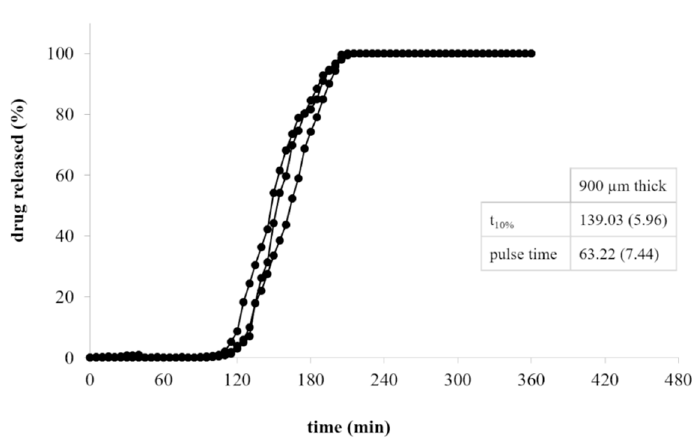
Figure 6. Release profiles of two-component systems composed of a PVA-based core containing AMY and printed with 50% infill and a 900 µm thick HPC coat (average release parameters and relevant CV, in brackets, are listed in boxes).